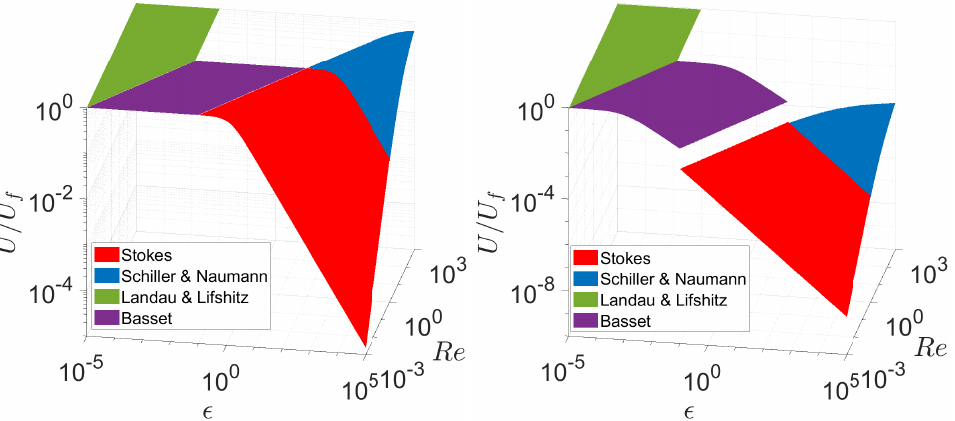
Figure 3. Normalized slip velocity amplitude, calculated with various drag models. ( left ) γ = 25,000 (corresponds to iron particles in hot air); ( right ) γ = 8 (corresponds to iron particles in water at